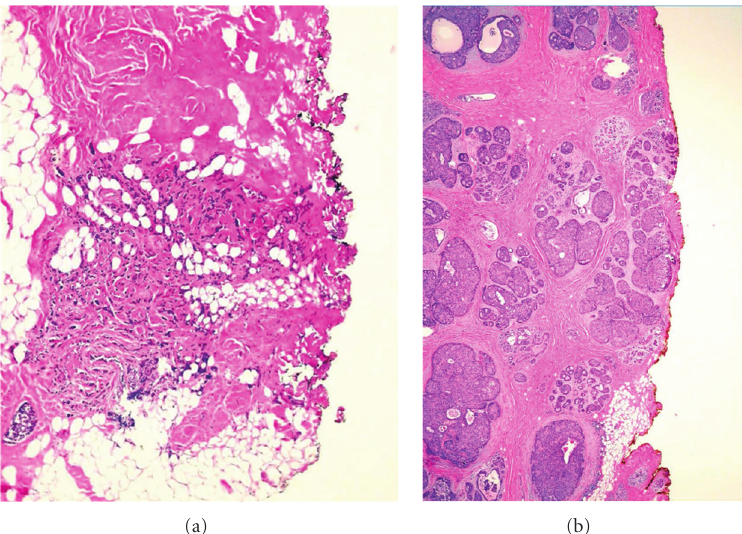
Figure 1: (a) Section of an invasive carcinoma that extends to and is transected in the surgical margin. (b) Section on extensive ductal carcinoma in situ focally transected in a surgical margin. (H and E).